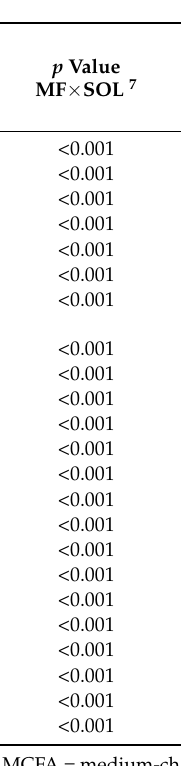
Table 4. Least-square means and standard errors of daily yields of milk, fat, protein and lactose, gross milk composition and fatty acid composition of cows milked once a day (OAD) and twice a day (TAD) in early, mid and late lactation during the 2020–2021 production